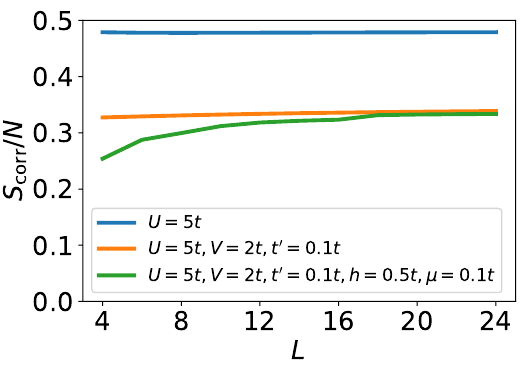
Figure 4: Correlation entropy as a function of different chain sizes. Three sets of parameters are used in the calculations for